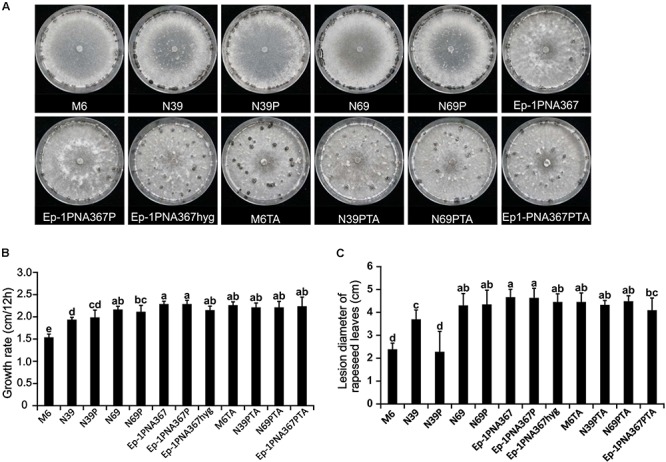
Biological properties of the S. sclerotiorum strain artificially infected by SsOLV4. Strains M6, N39, and N69 are the protoplasm-regenerants of strain PX14A4; strains N39P, N69P, and Ep-1PNA367P are the strains transfected by synthesized RNA. A synthesized virus was also transmitted to Ep-1PNA367 through hyphal anastomosis to obtain strains M6TA, N39PTA, N69PTA, and Ep-1PNA367PTA. (A) Colony morphology of strains (PDA, 14 days, 21°C). (B) Radial mycelial growth rate (PDA, 21°C). (C) Lesion diameter on rapeseed leaves (21°C). In each histogram, bars labeled with the same letters are not significantly different (p > 0.05) according to the least significant difference test.